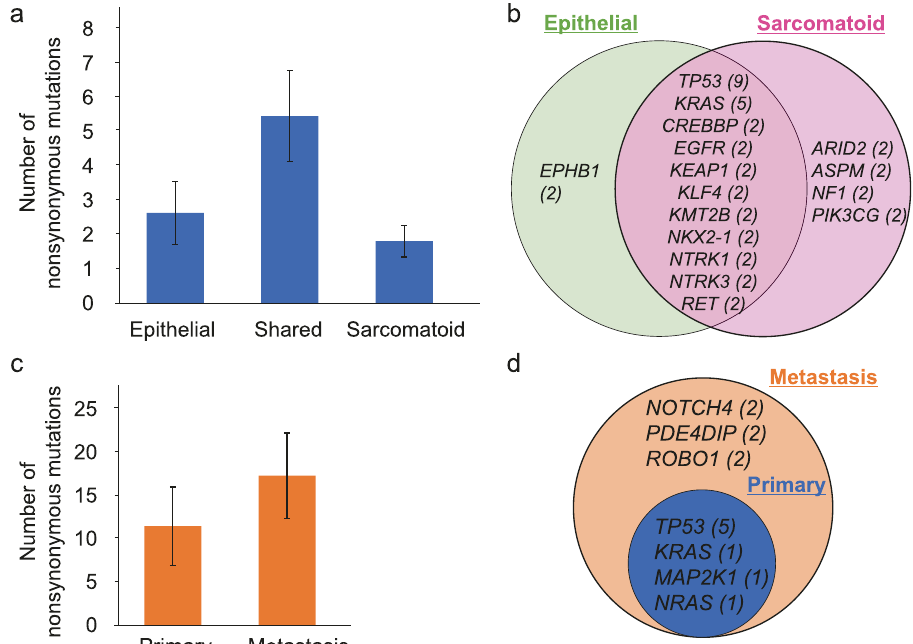
Fig. 2 Comparison of genomic alterations according to the intratumoral component and primary or metastatic tissue. a Bar chart of the average numbers of shared and unshared nonsynonymous mutations between the epithelial and sarcomatoid components. b Individual repeatedly detected mutations in each component. Activating mutations were shared between components, while ARID2 , ASPM , NF1 , and PIK3CG mutations were only detected in sarcomatoid components. The number of patients who harbor the mutations of indicated genes is shown in parentheses. c Average numbers of nonsynonymous mutations in primary and metastatic tumors, revealing more in metastatic tumors relative to primary tumors. d Individual mutations detected in primary and metastatic tumors. The number of patients who harbor the mutations of indicated genes is shown in parentheses. Error bars, standard error of the